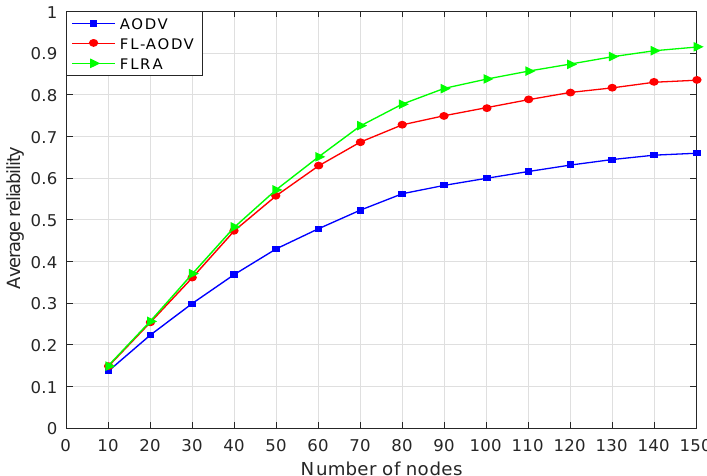
Figure 9. Comparison of average reliability of paths.